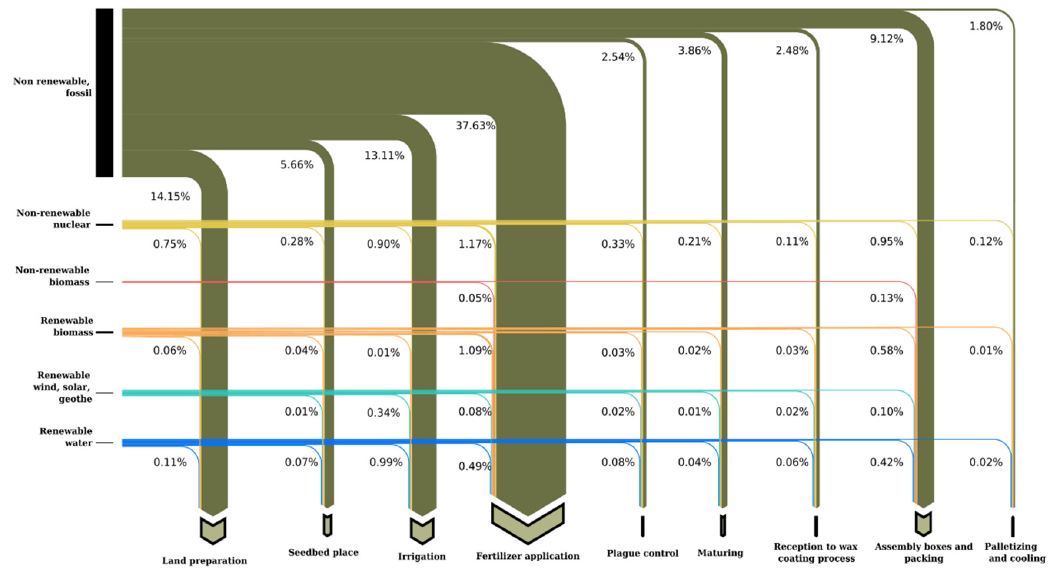
Figure 9. The energy footprint of packed pineapple by main unit processes.